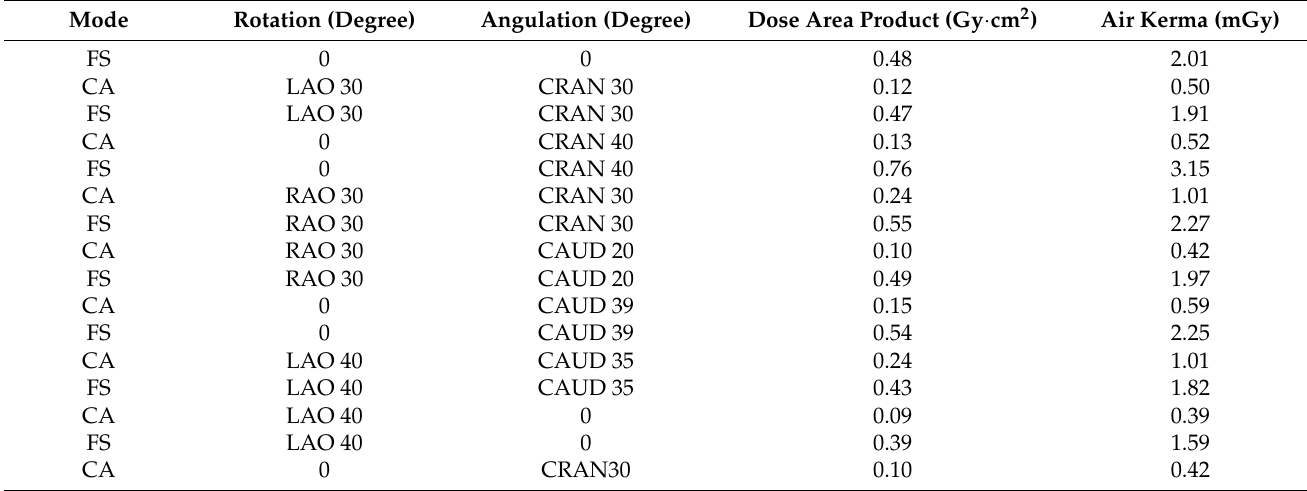
Table 5. The dose-report for cardiac